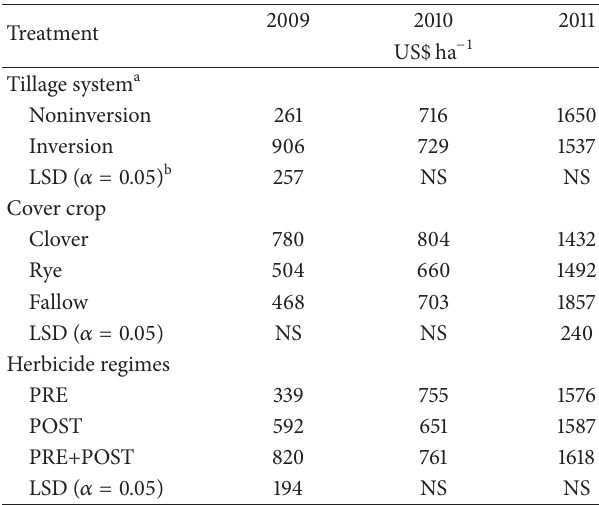
Table 6: Influence of tillage, cover crop, and herbicide treatments on net returns (US$ ha −1 ) by